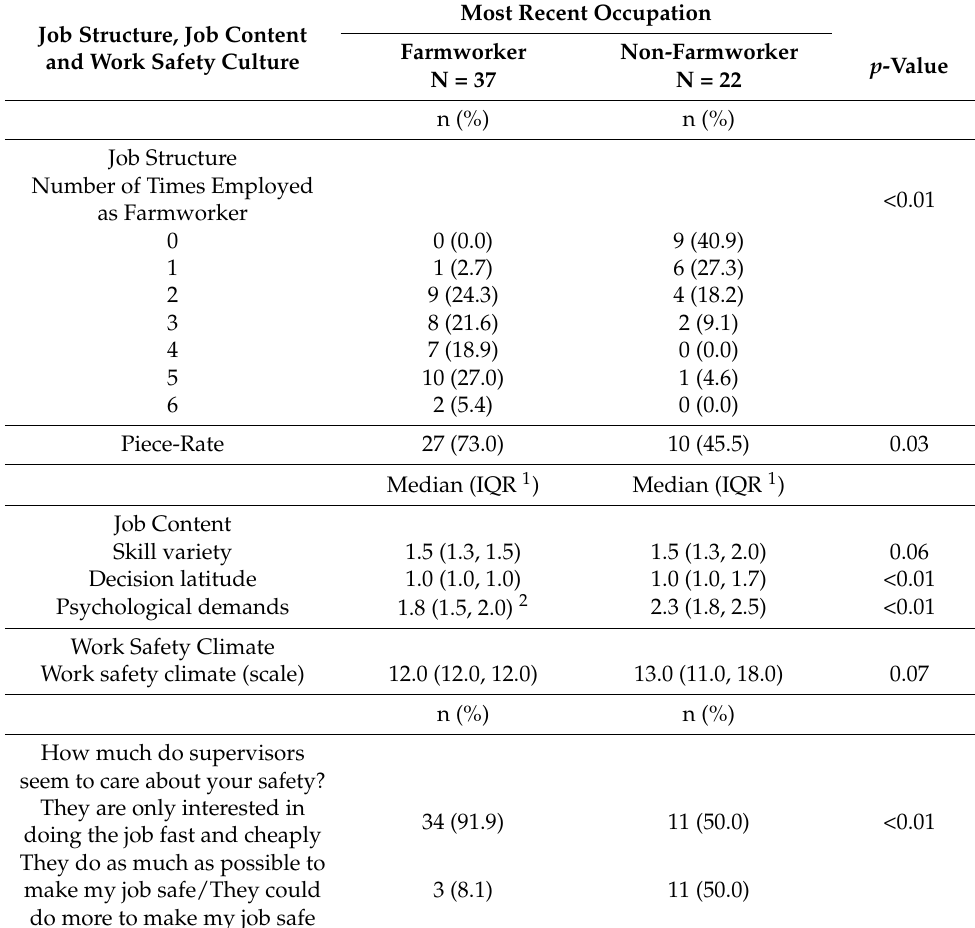
Table 7. Job Content and Work Safety Culture Compared: Latinx Women in Farmworker Families Employed in the Past Year at Follow-Up 5 Questionnaire as Farmworkers versus Non-Farmworkers, North Carolina (N =